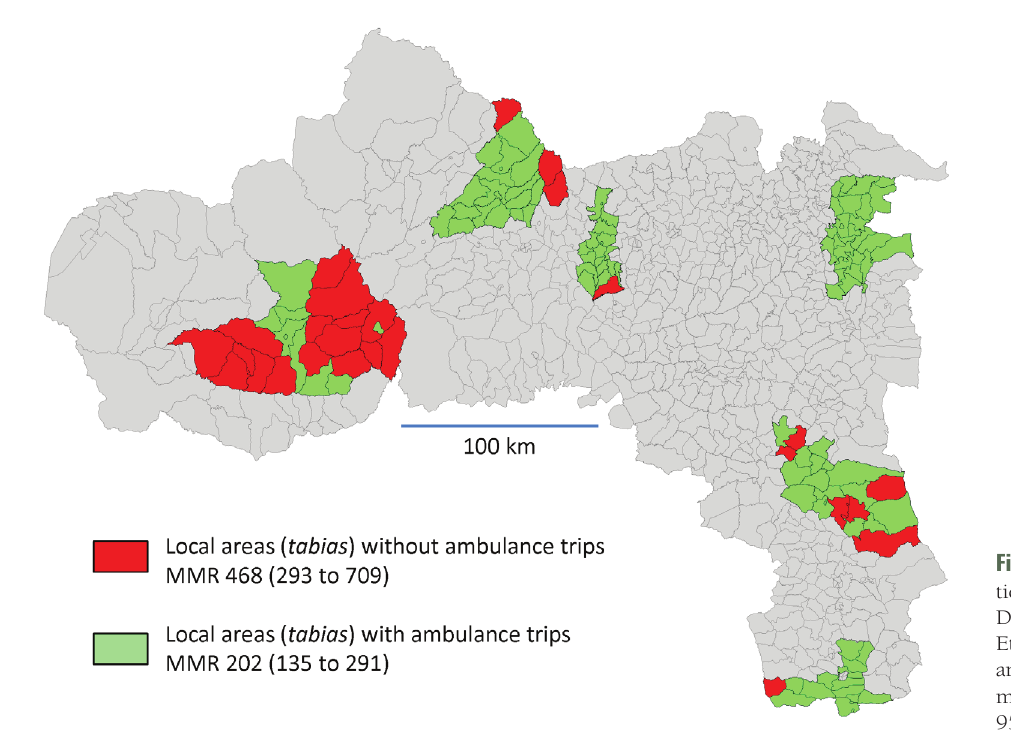
Figure 4. Ambulance utilisa- tion within the six study Districts in Tigray Region, Ethiopia, by local area ( tabia ) and associated maternal mortality ratios (MMR) with 95% confidence